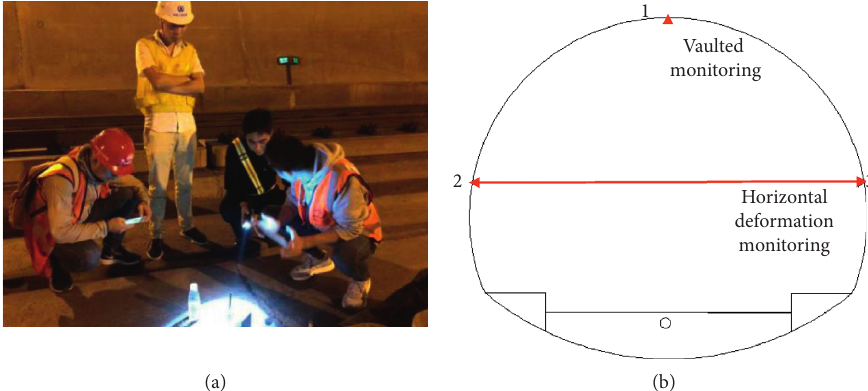
Figure 16: Monitoring of settlement and horizontal deformation of the existing tunnel. (a) Monitoring site. (b) Layout of measuring